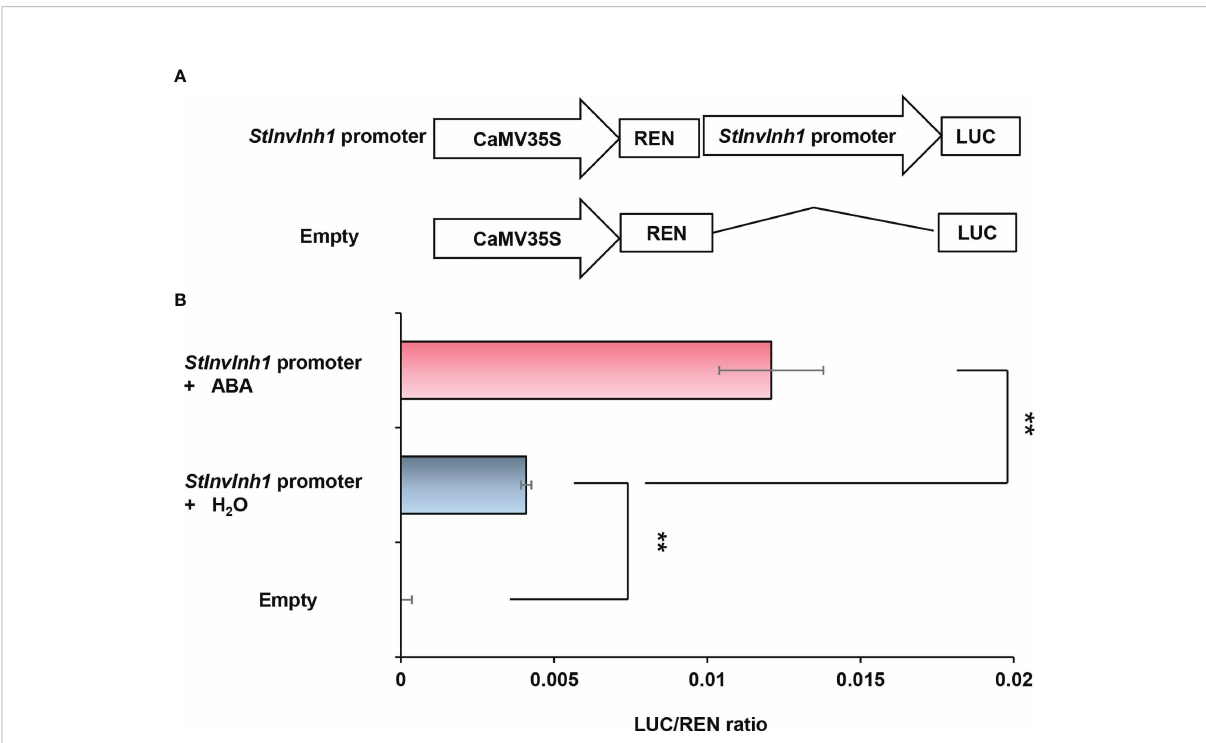
FIGURE 2 Estimation of the promoter activity of the 2.2-kb StInvInh1 promoter sequence by the dual-luciferase reporter assays. (A) Schematic representation of the double-reporter plasmids used in the assay. The double-reporter plasmids contain the StInvInh1 or empty promoter fused to LUC luciferase and REN luciferase driven by CaMV35S. (B) The promoter activity of the 2.2-kb StInvInh1 promoter sequence. The dual- luciferase reporter vectors were introduced into tobacco leaves by Agrobacterium tumefaciens strain GV3101. The in fi ltrated tobacco leaves were spayed by ABA (50 mM) or H 2 O. After 48 h from the in fi ltration, LUC and REN luciferase activities were assayed. Each value represents the means of three biological replicates, and vertical bars represent the S.D. **Signi fi cant differences in values (P < 0.01) by Student ’ s t-test.